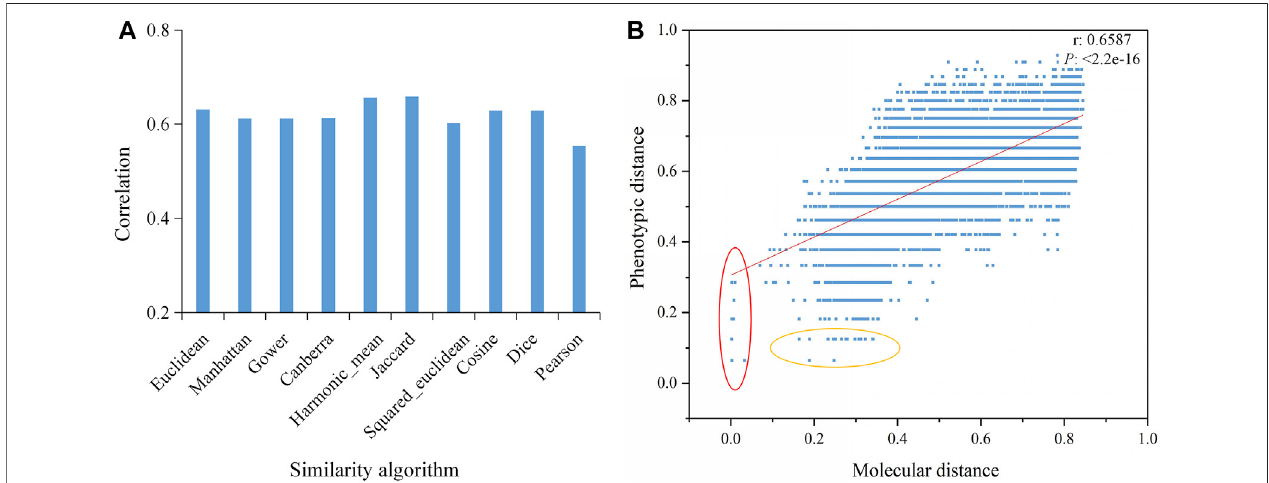
FIGURE 4 | Correlations between the molecular and phenotypic distances based on different algorithms. (A) Correlations based on 10 similarity algorithms. (B) Correlation between the molecular and phenotypic distances of varieties based on the Jaccard algorithm. The red oval represents small molecular distances but large phenotypic distances, and the yellow oval represents small phenotypic distances but large molecular distances. P is the signi fi cance level, and r is the correlation coef fi cient.